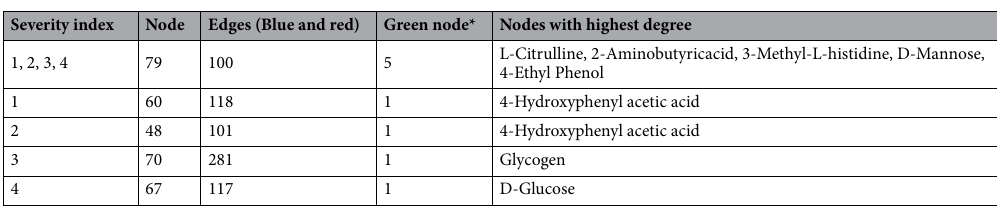
Table 3. Summary of nodes and edges of metabolic network from various indices. * nodes with highest node degree and betweenness centrality.